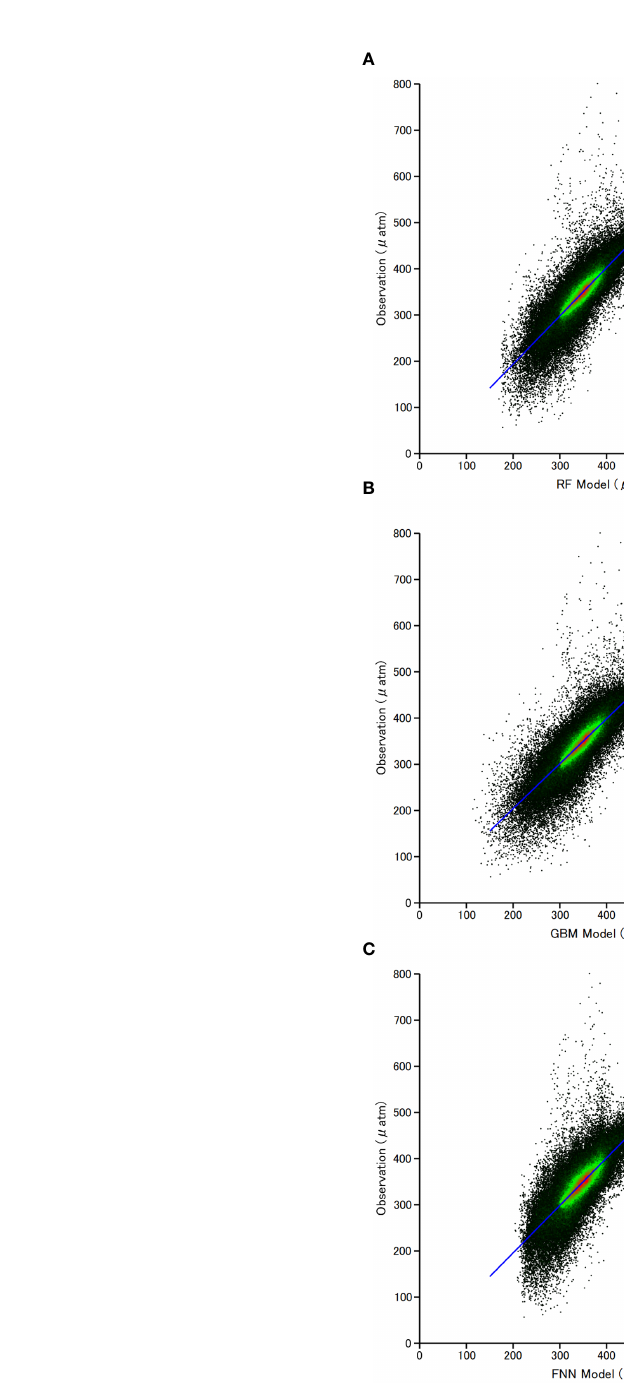
FIGURE 3 Model predictions vs observations of ocean CO2 fugacity using normalized data with the trends in Table 3. Predictions come from 41 validations for each target year between 1980 and 2020. The colour indicates the density of data points. (A) Results of the RF model. (B) Results of the GBM model. (C) Results of the FNN